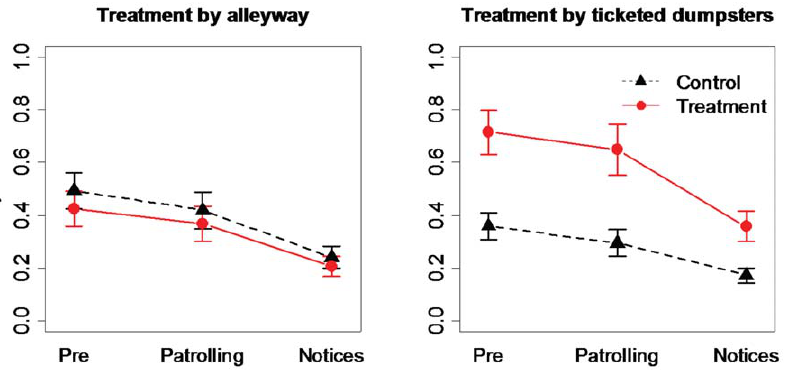
Figure 5. Results of elevated enforcement experiment. Differences in mean ( 6 1 SE) probability of violation in core area dumpsters by treatment group for the pre-treatment (Pre), daily patrolling treatment (Patrolling), and written notices treatment (Notices) periods for a 2008 experiment testing the efficacy of enforcement as a management tool in reducing availability of garbage to bears in the core business area of Aspen, Colorado, USA. Treatment by alleyway included all dumpsters in the daily patrolled alleyways as treatment, whereas treatment by ticketed dumpsters included only dumpsters receiving written notices as treatment.